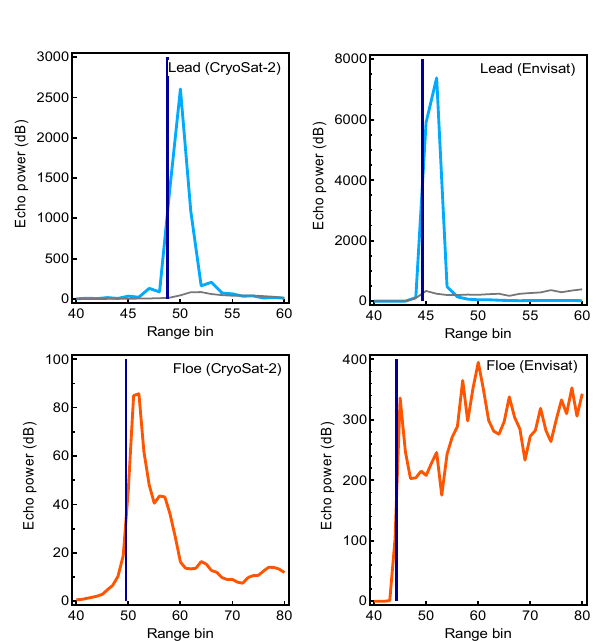
Figure 1. Waveform example for a lead (top panels) and a floe (bot- tom panels) for CS-2 (left panels) and Envisat (right panels). The blue line shows the retracking point of each waveform. Notice the different scales on the y axis: lead detections have a much higher echo power and a steeper leading edge than waveforms originating from ice only detections. To make the different echo powers better visible, the floe waveforms are shown in the upper figures (leads) in grey. Waveforms from CS-2 and Envisat do not originate from the same position but rather show an arbitrary